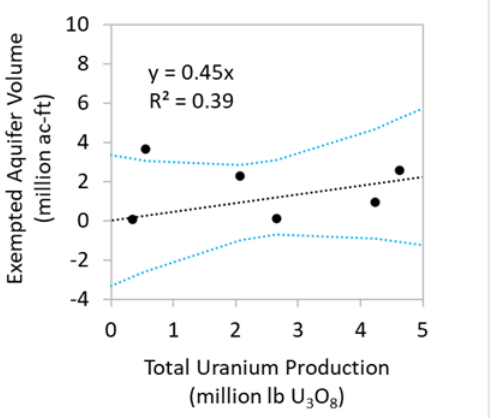
Figure 7. Exempted aquifer volume as a function of uranium produced (as lb U 3 O 8 ) for the six ISR operations listed in Table A1. This volume is the total physical volume of aquifer computed by multiplying the exempted area by the exempted aquifer thickness. Compiled data used to construct these graphs as well as associated references are publicly available online [18]. Note: ac-ft = acre-feet. Black line is the linear trend line and blue lines are the 95 percent confidence intervals.